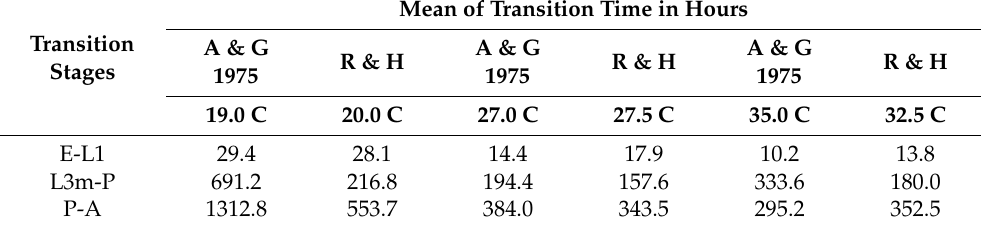
Table 6. Comparison between Ash and Greenberg [9] and Roe and Higley of Lucilia sericata mean transition times.